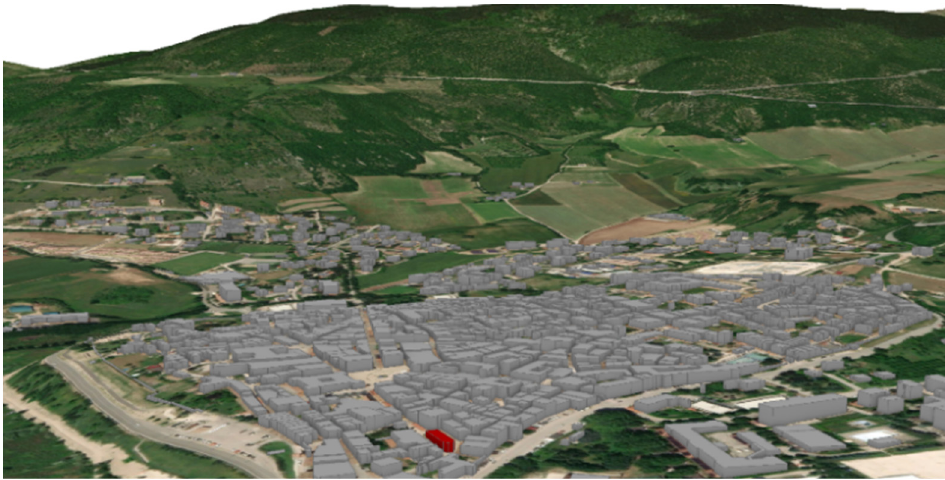
Figure 5. LoD1 and the 2.5 D visualization in ArcGIS Pro.